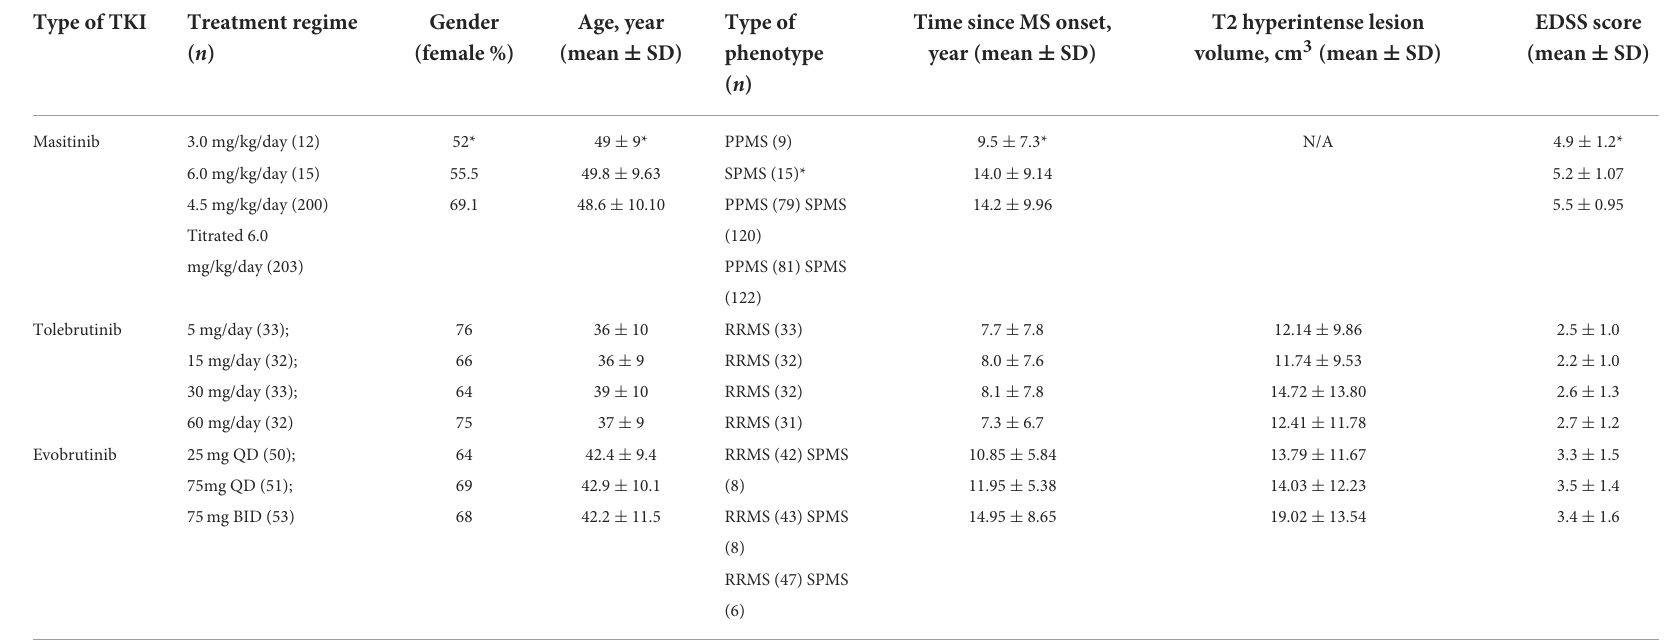
TABLE 2 Characteristics of the included tyrosine kinase